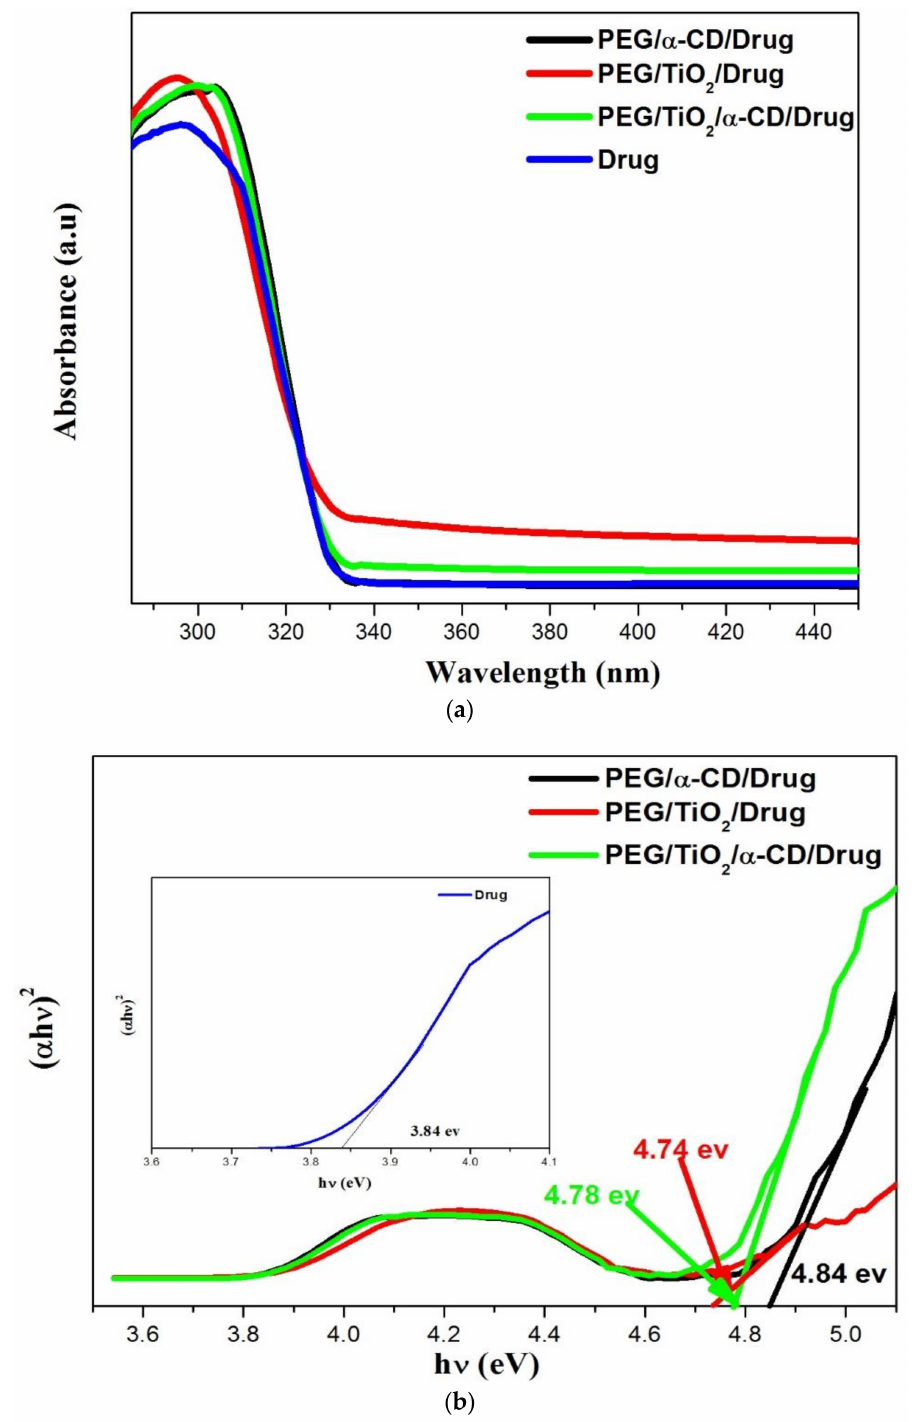
Figure 7. ( a ) UV–Vis absorption spectra of the drug before and after loading on the polymers, and ( b ) the corresponding estimated values for the energy